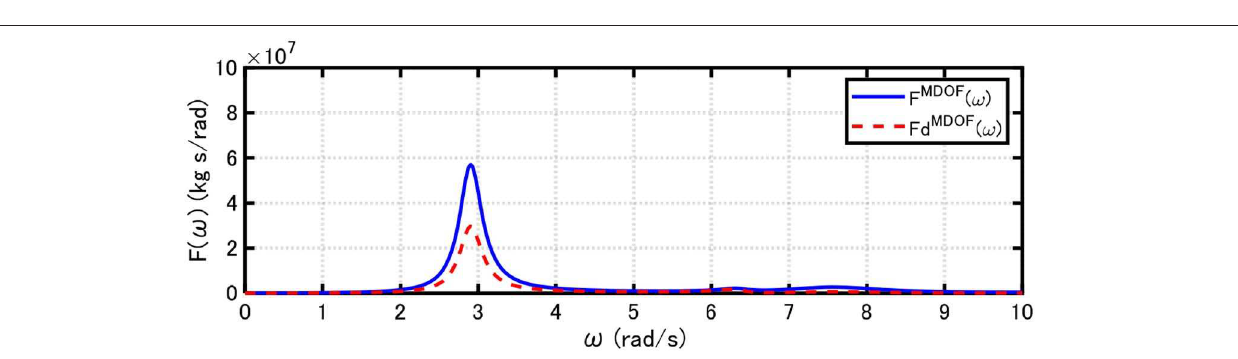
FIGURE 12 | Energy transfer functions for total system and viscous damper installed at connection point between upper and lower strong-back core frames. model or the SDOF model (Takewaki, 2004a,b). The difference model, it overestimates the area of the energy transfer function between the MDOF model and the SDOF model is due to as an index for energy dissipation performance of the dampers the difference of mass (the SDOF model disregards the mass in the MDOF model. There also exists an optimal damper of the lower strong-back core frame). It can also be observed damping coefficient maximizing the area of the energy transfer that, while the SDOF model underestimates the area of the function for the damper, i.e., the most effective damper damping energy transfer function of the total input energy in the MDOF coefficient. Those damper quantities are shown in Figure 13A